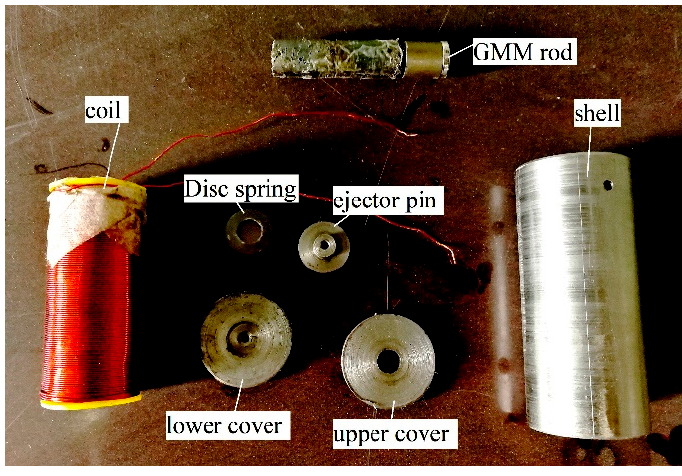
Figure 10. Prototype of SGMA.